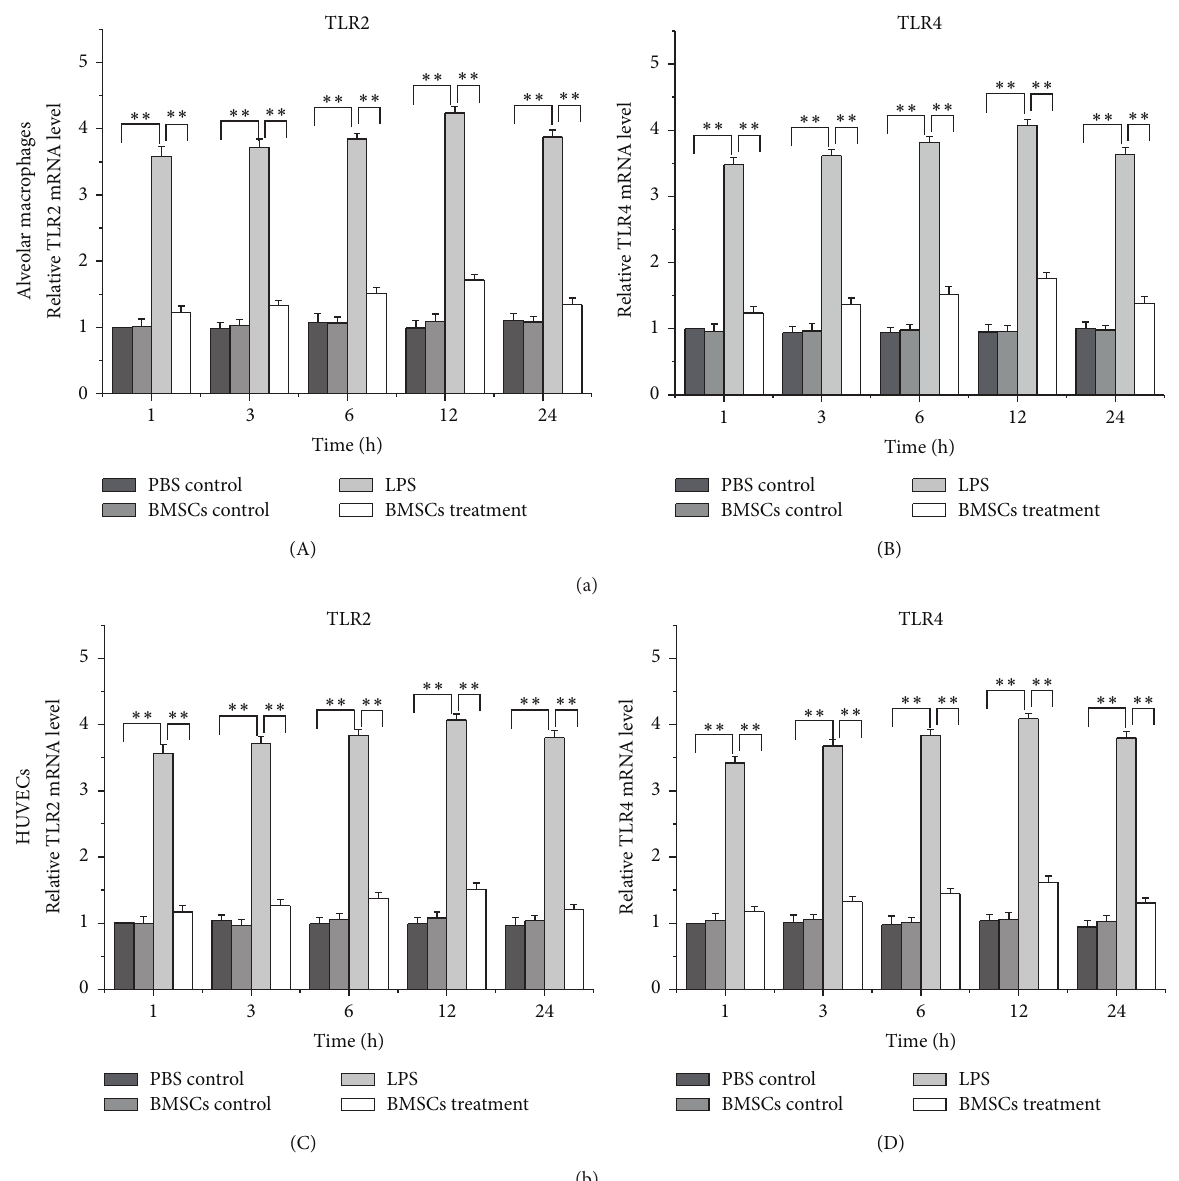
Figure 3: Coculture with BMSCs attenuates the activity of LPS to induce expressions of TLR2 and TLR4 in alveolar macrophages (a) and HUVECs (b) at the mRNA level. The total RNAs were extracted from the cultured alveolar macrophages and HUVECs treated (1) PBS control, (2) BMSCs, (3) LPS, and (4) BMSCs and LPS. The expressions of TLR2 and TLR4 were determined by real-time RT-PCR. Data are expressed as the mean ± SD from three experiments. ∗ 𝑃 < 0.05 , ∗∗ 𝑃 < 0.01